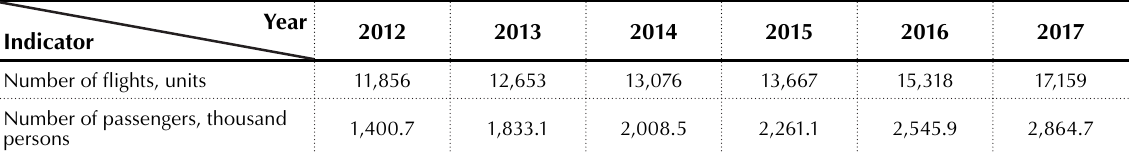
Source: National Tourism Administration of